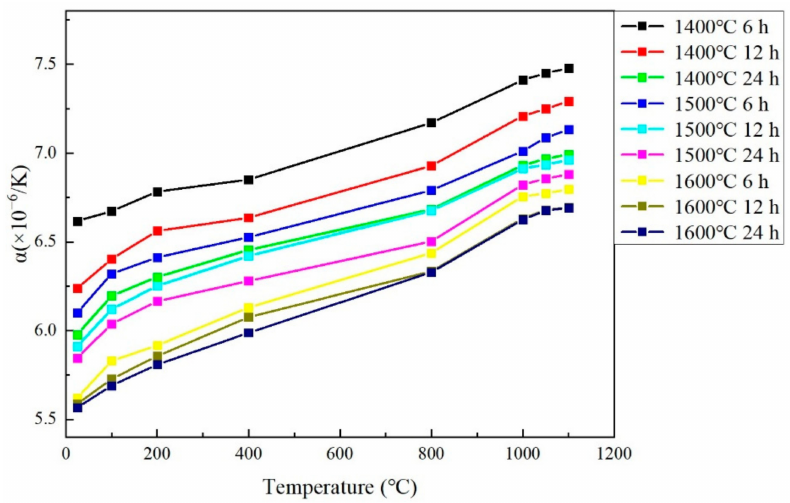
Figure 5. The sintered Gd 2 O 3 bulks’